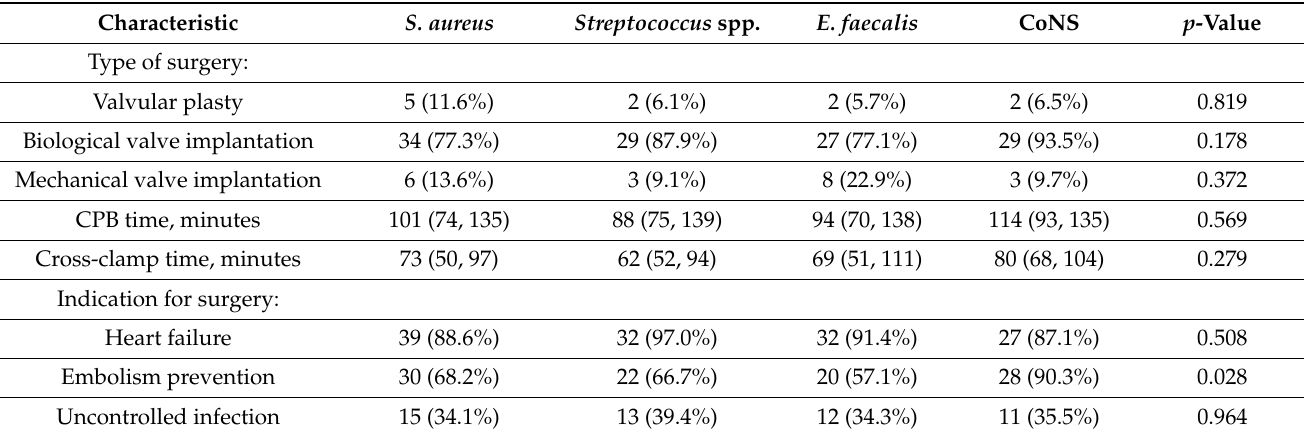
Table note: CoNS—coagulase-negative staphylococci; CPB—cardiopulmonary bypass.